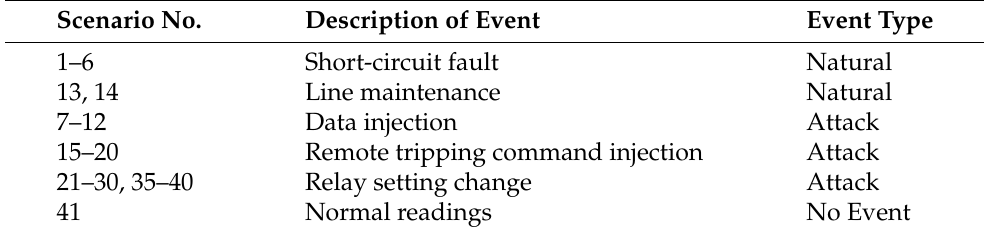
Table 1. Summary of operational scenarios and events. Scenario No.